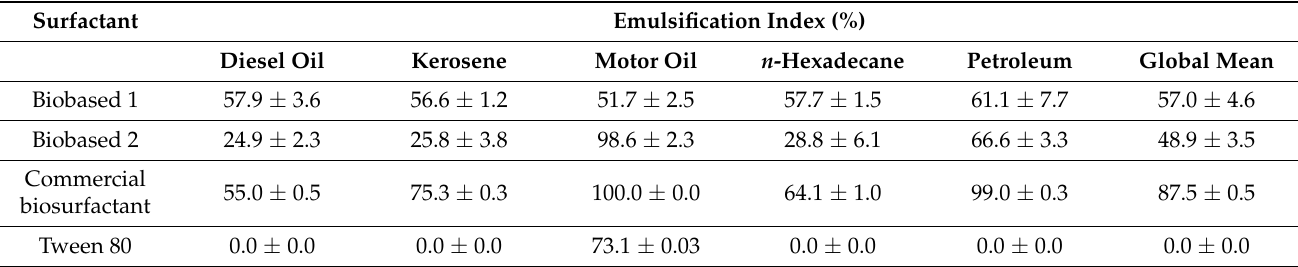
Table 3. Emulsification indexes for different hydrocarbons of the surfactants tested. Results are expressed as means ± SD ( n = 3), where means are significant at p <